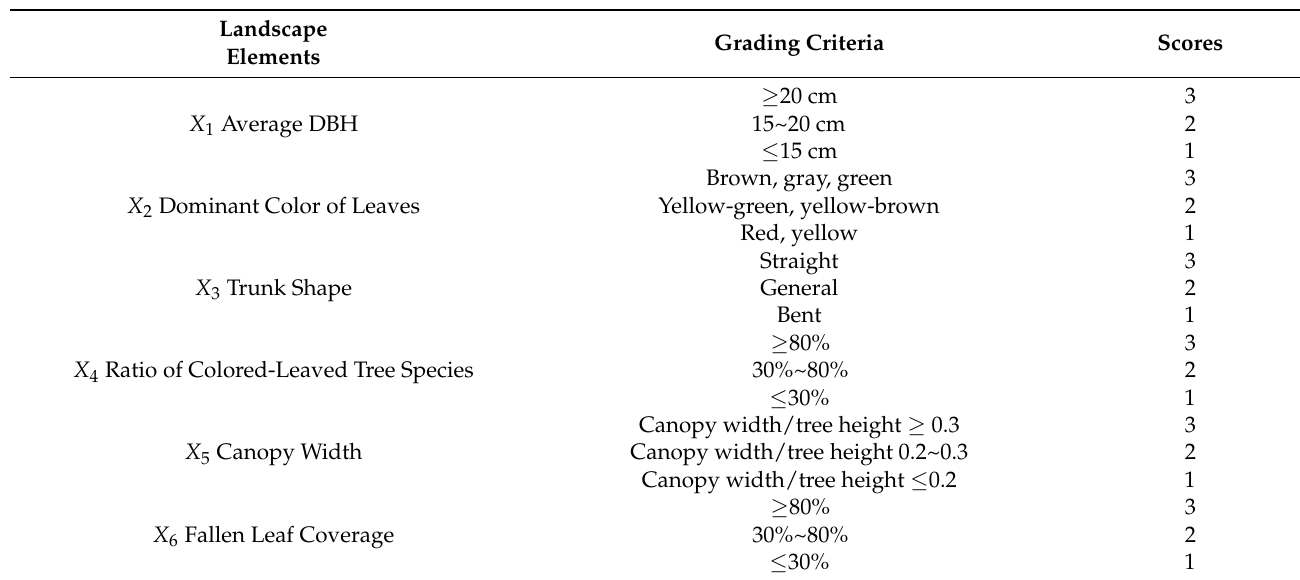
Table 3. Landscape elements and grading criteria for the ground observation perspective.